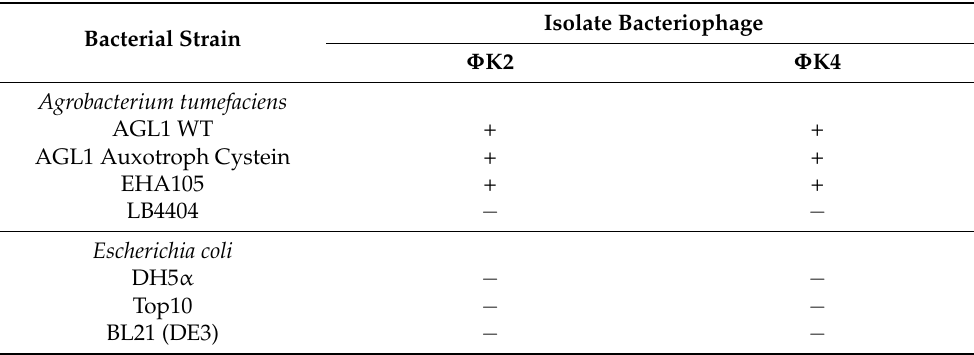
Table 2. Host spectrum of Φ K2 and Φ